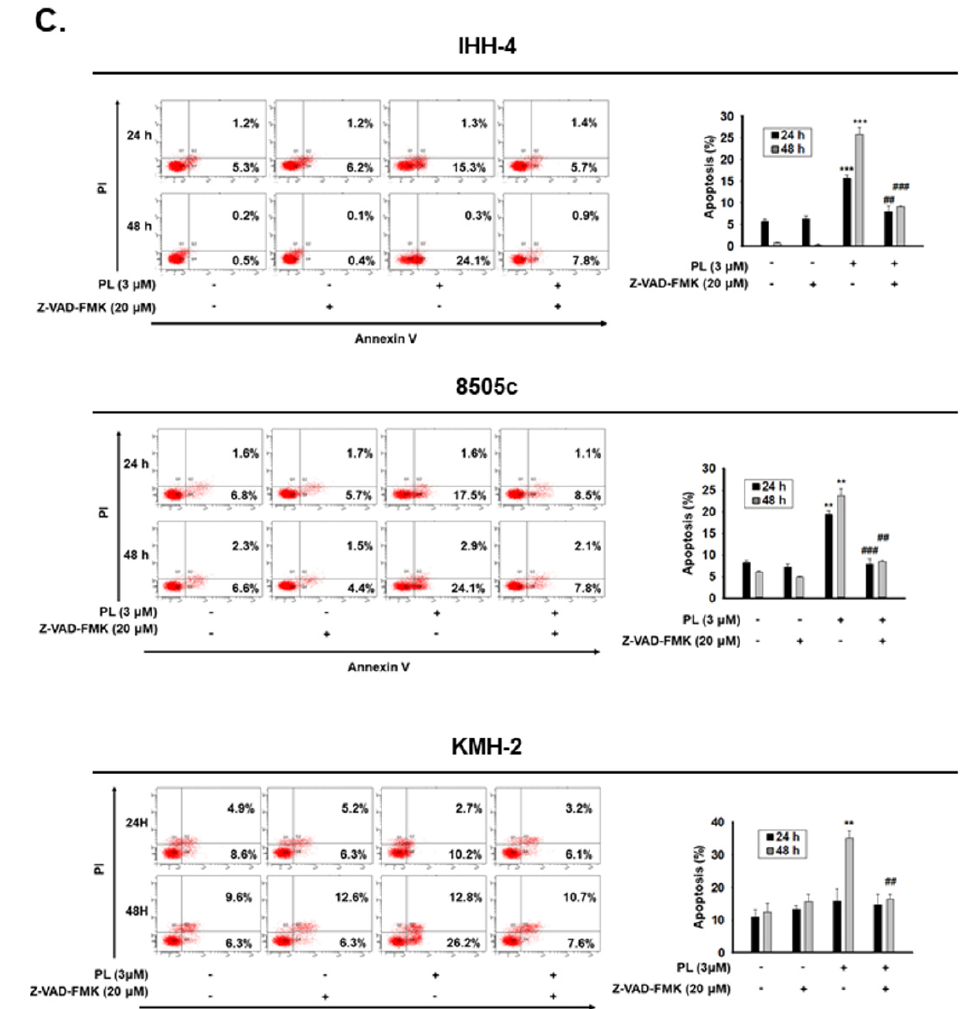
Figure 3. Activation of mitochondria-dependent cellular apoptosis by piperlongumine (PL) in human thyroid cancer cells. ( A ) Three human thyroid cancer cells were incubated with PL, and the expression of caspases and poly (ADP-ribose) polymerase (PARP) was examined by western blotting. ( B ) Z-VAD-FMK was used to suppress PL-mediated caspase-dependent apoptosis, and the activation of caspase and PARP was assessed by western blots, and ( C ) the cellular apoptosis was determined with flow cytometry. Dimethyl sulfoxide (DMSO) was used to be a negative control. GAPDH was used as a loading control. Three independent experiments were conducted. The data include western blotting, and the flow cytometry dot plot was shown with a representative experiment. * indicated comparing with the untreated group and # showed comparing with PL treated group. ** and ## indicates p < 0.01. *** and ### indicates p < 0.001.